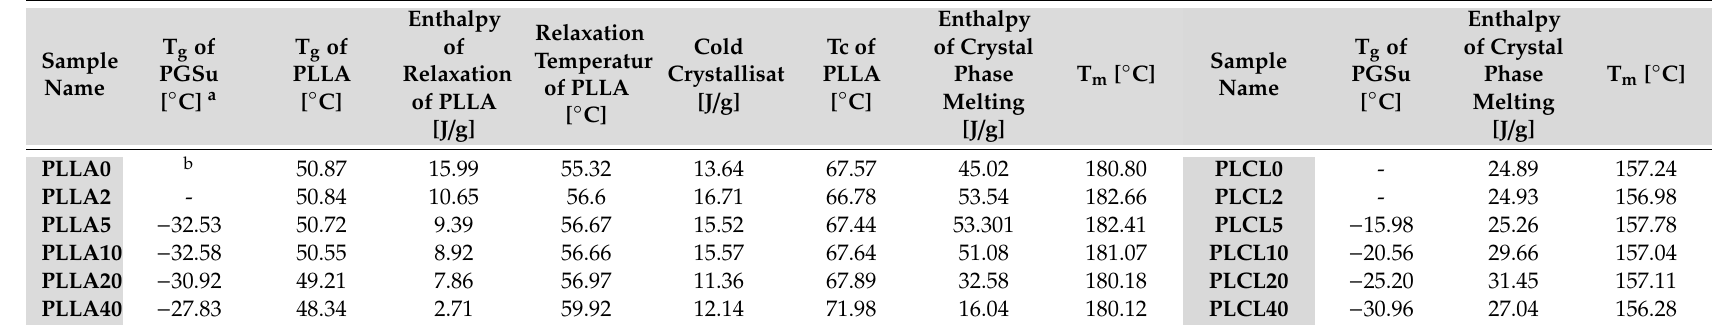
Table 2. Characteristic enthalpies and temperatures of bicomponent fibres with PGSu additive in relation to PLLA and PLCL determined from di ff erential scanning calorimetry